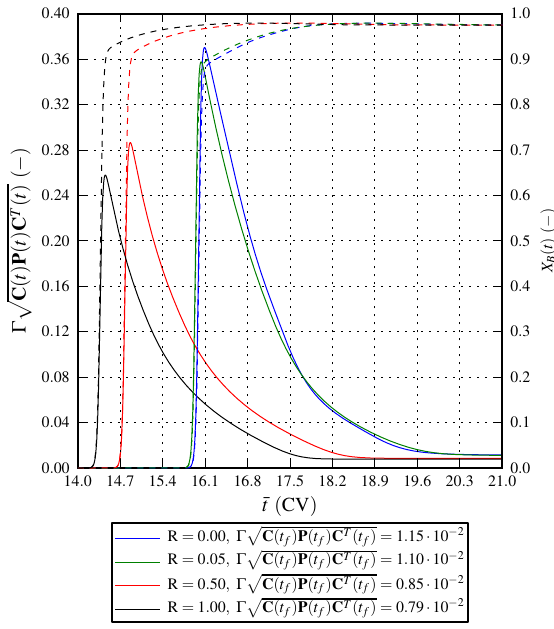
Figure 12. Target component purity, X B ( t ) , (dashed lines) and associated back-off term, Γ C ( t ) P ( t ) C T ( t ) , (solid lines) as a function of time for the nominal elution trajectories depicted in Figure (cid:112)